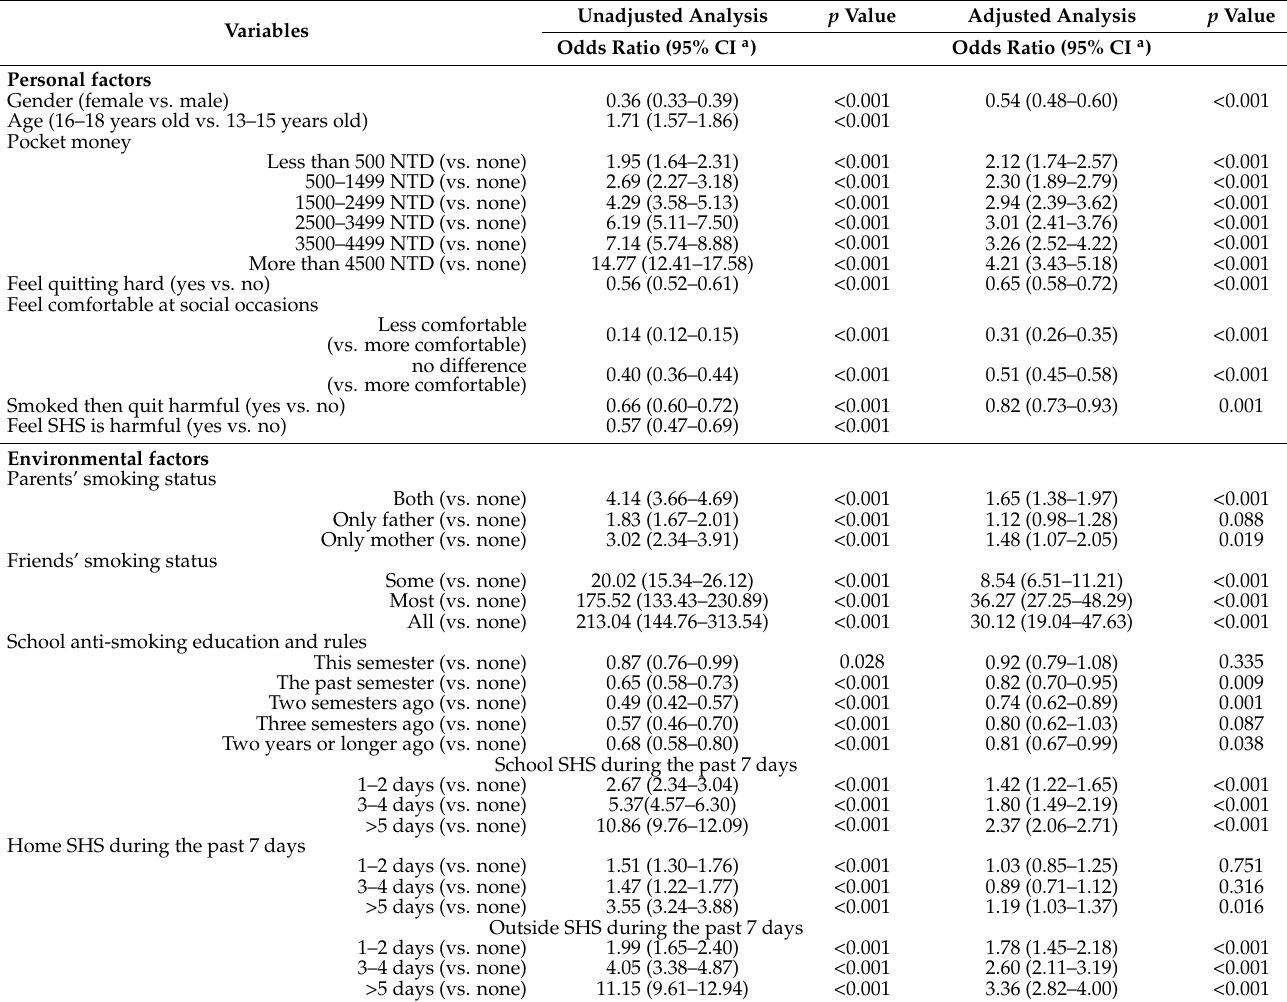
Table 2. Factors associated with current cigarette smoking in adolescents ( n =